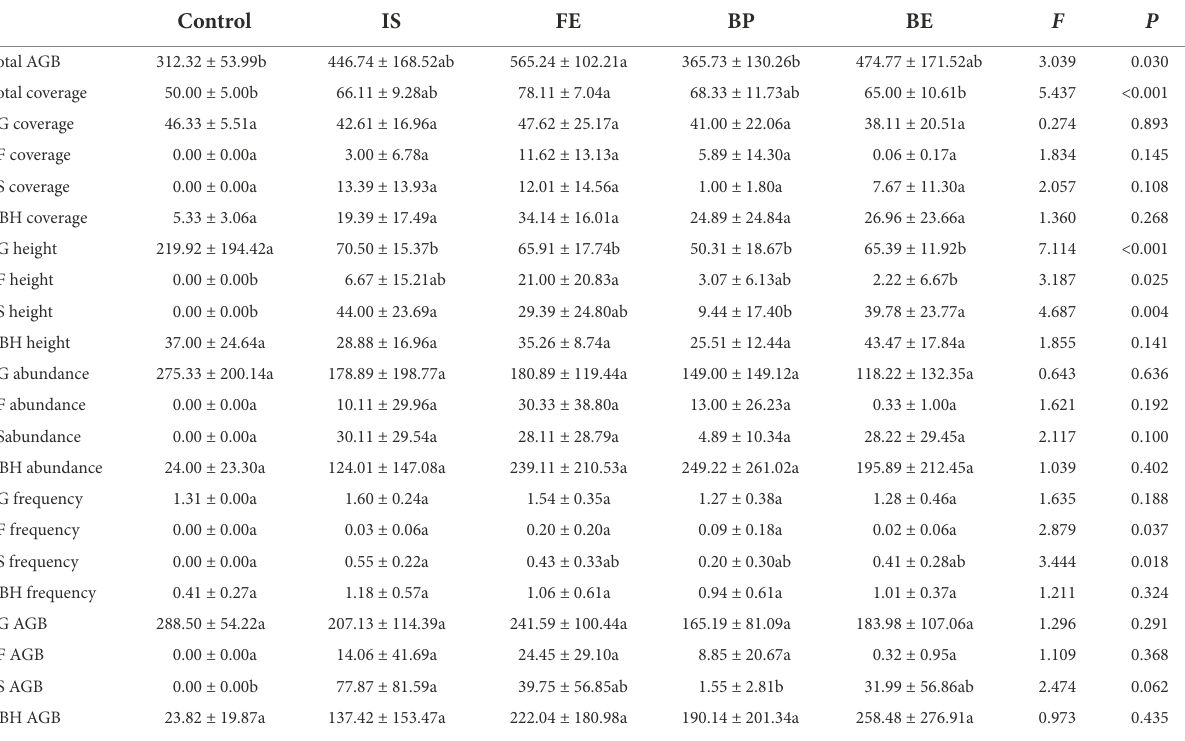
TABLE 2 One-way ANOVA analysis of the effects of PV panels on plant communities and functional groups (PG: perennial grasses; PS: perennial sedges; PF: perennial forbs; ABH: annual and biennial